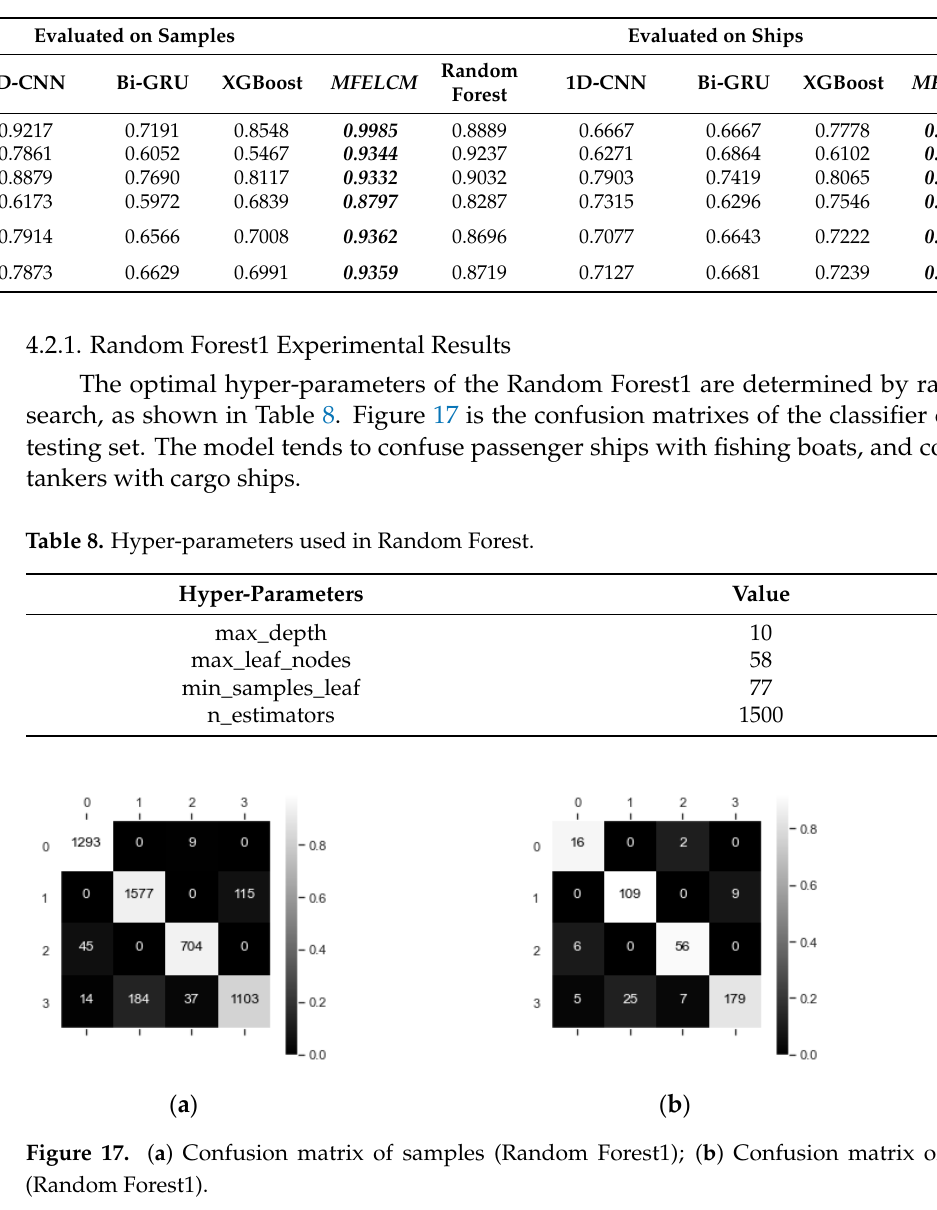
Table 7. Performance evaluation of base classifiers and MFELCM.